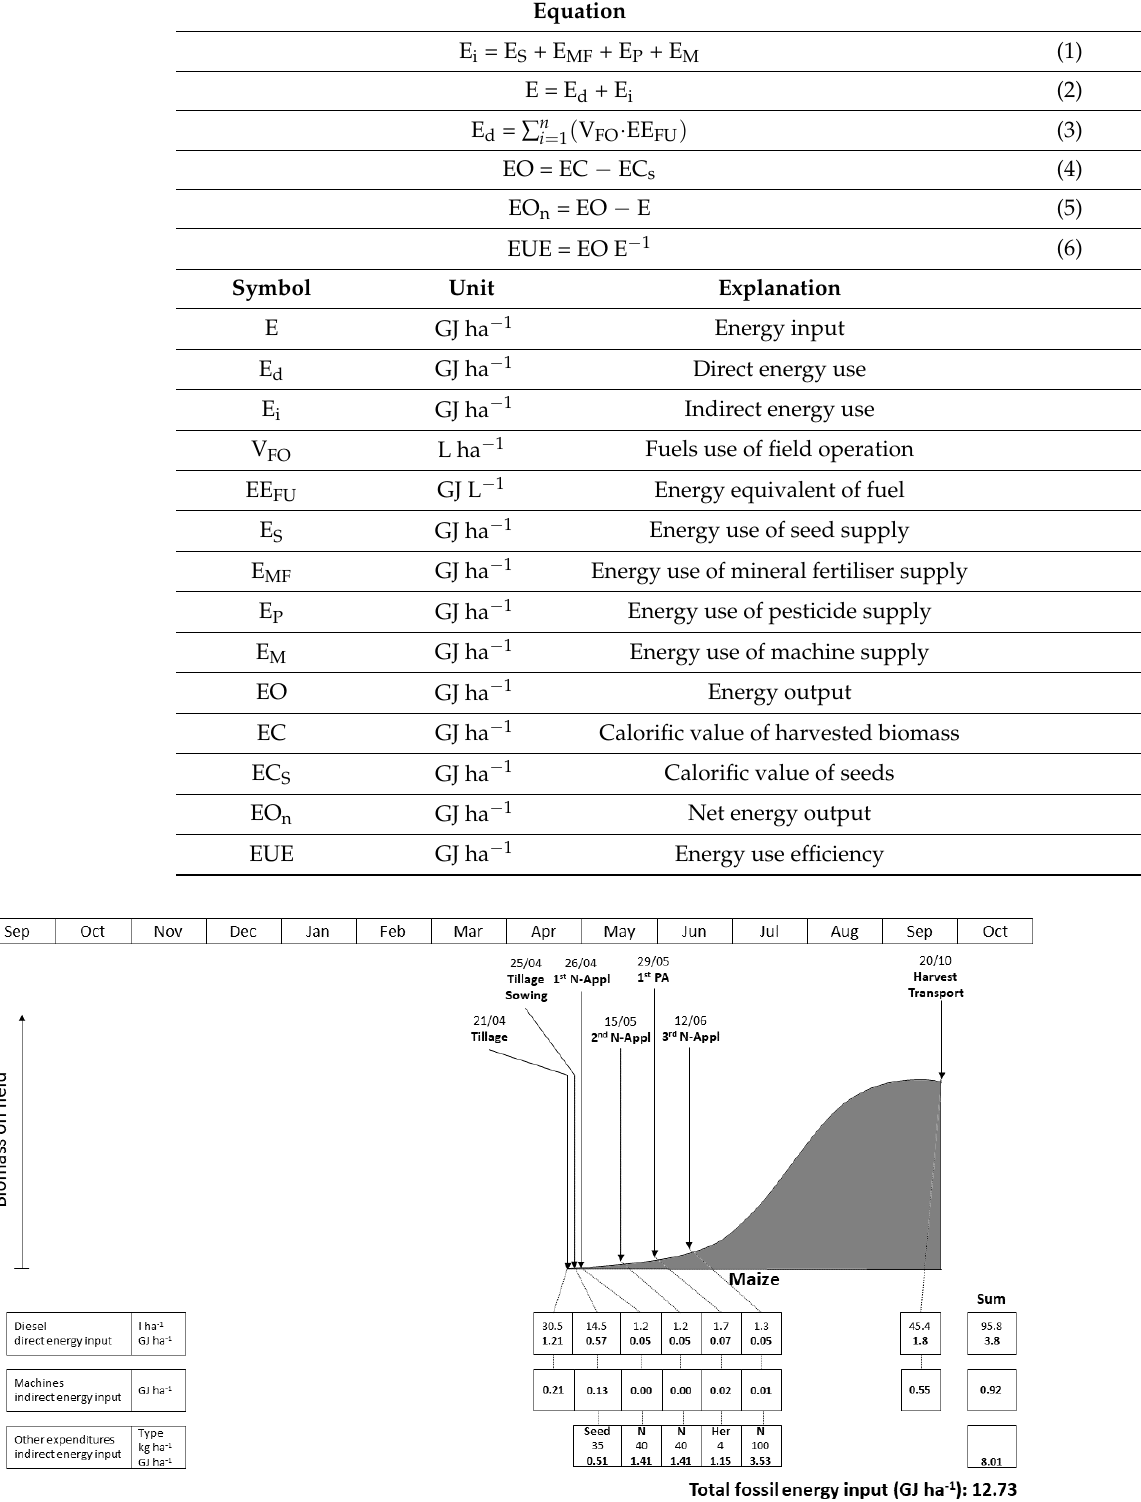
Table 3. Net energy output and energy efficiency were calculated based on Equations (1)–(6).